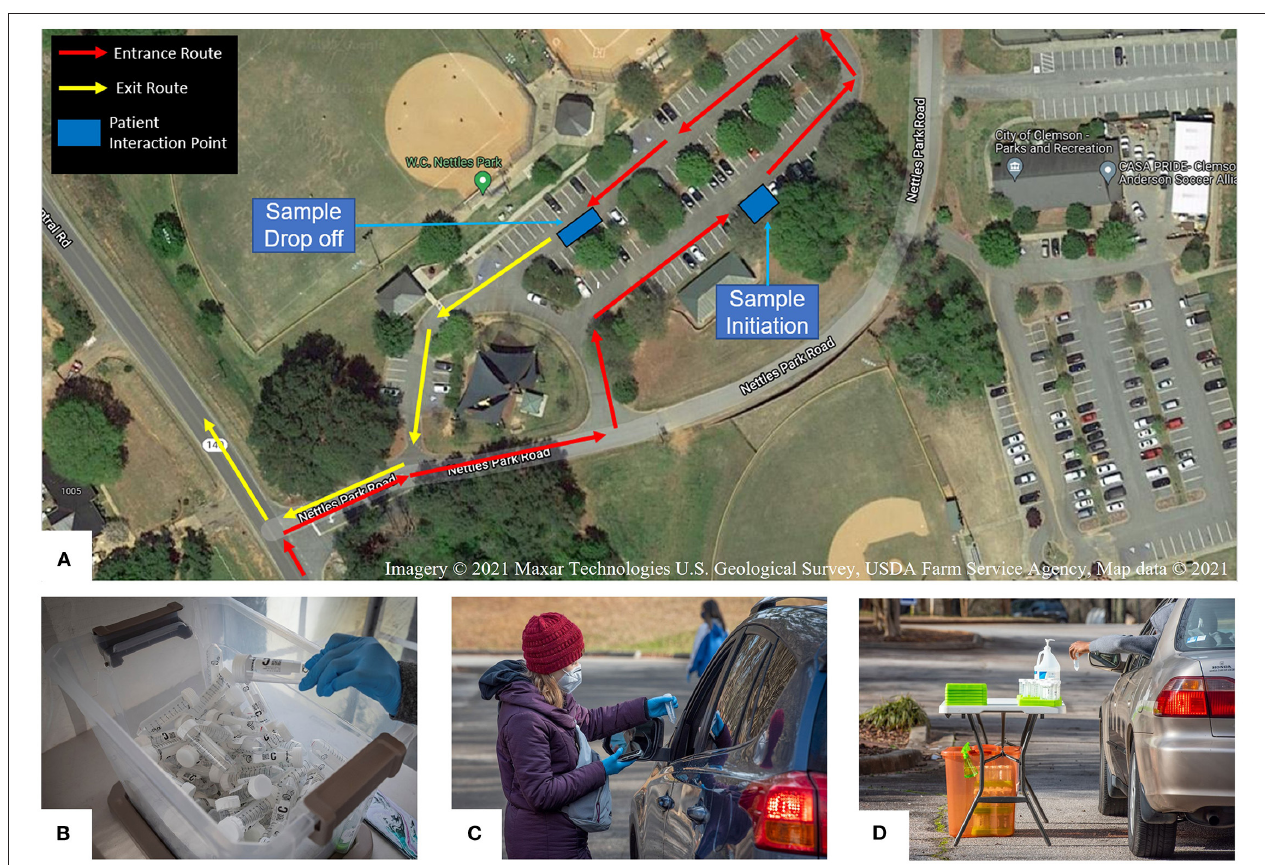
FIGURE 1 | REDDI Laboratory community testing operation. (A) Overhead diagram of the community testing site layout. (B) Box of 50ml saliva collection tubes labeled with unique QR codes. (C) Collection staff initiating a test for a community member. (D) Community member placing self-collected sample into a collection tray. Filled sample trays were placed in the orange biohazard box for transportation to the